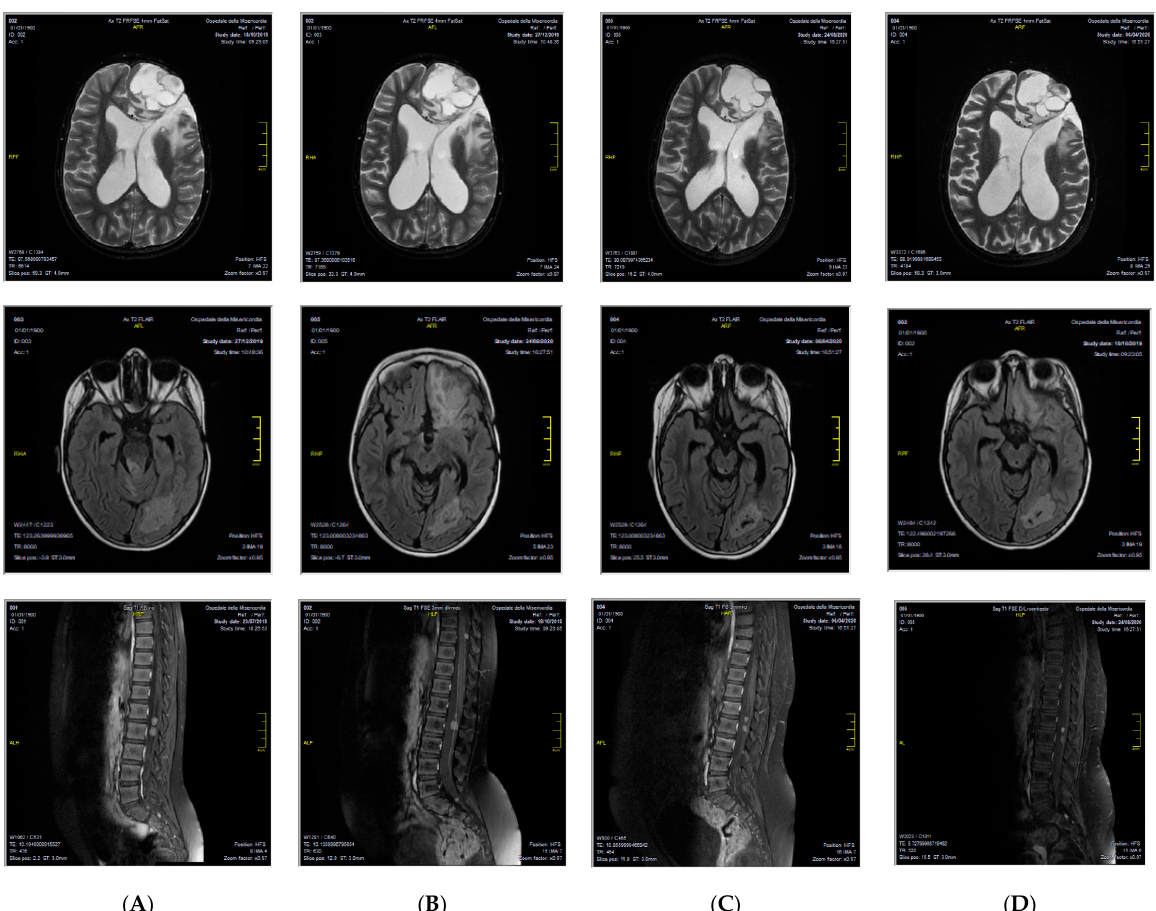
Figure 1. CNS MRI patient evaluation during therapy with nivolumab and sirolimus, showing a substantially stable dis- ease in the brain and in the spinal cord at different time points. ( A ) January 2020; ( B ) April 2020; ( C ) August 2020; ( D ) January 2021.